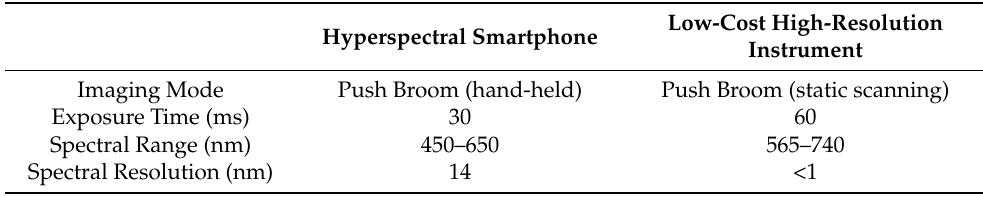
Table 1. Settings Used for Each